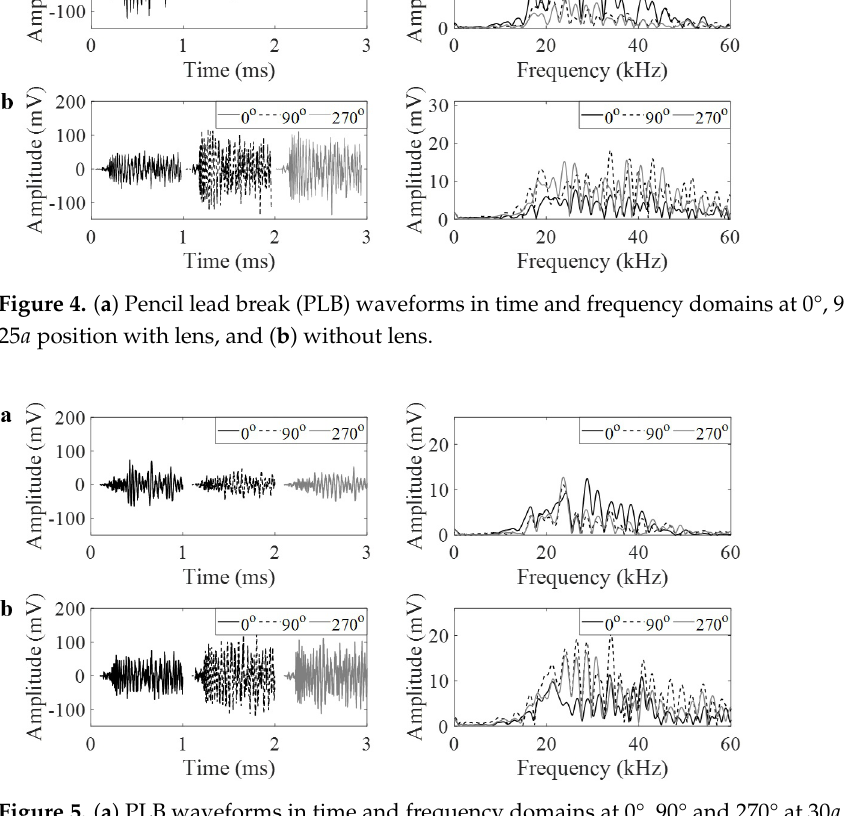
Figure 5. ( a ) PLB waveforms in time and frequency domains at 0°, 90° and 270° at 30 a position with lens, and ( b ) without lens.